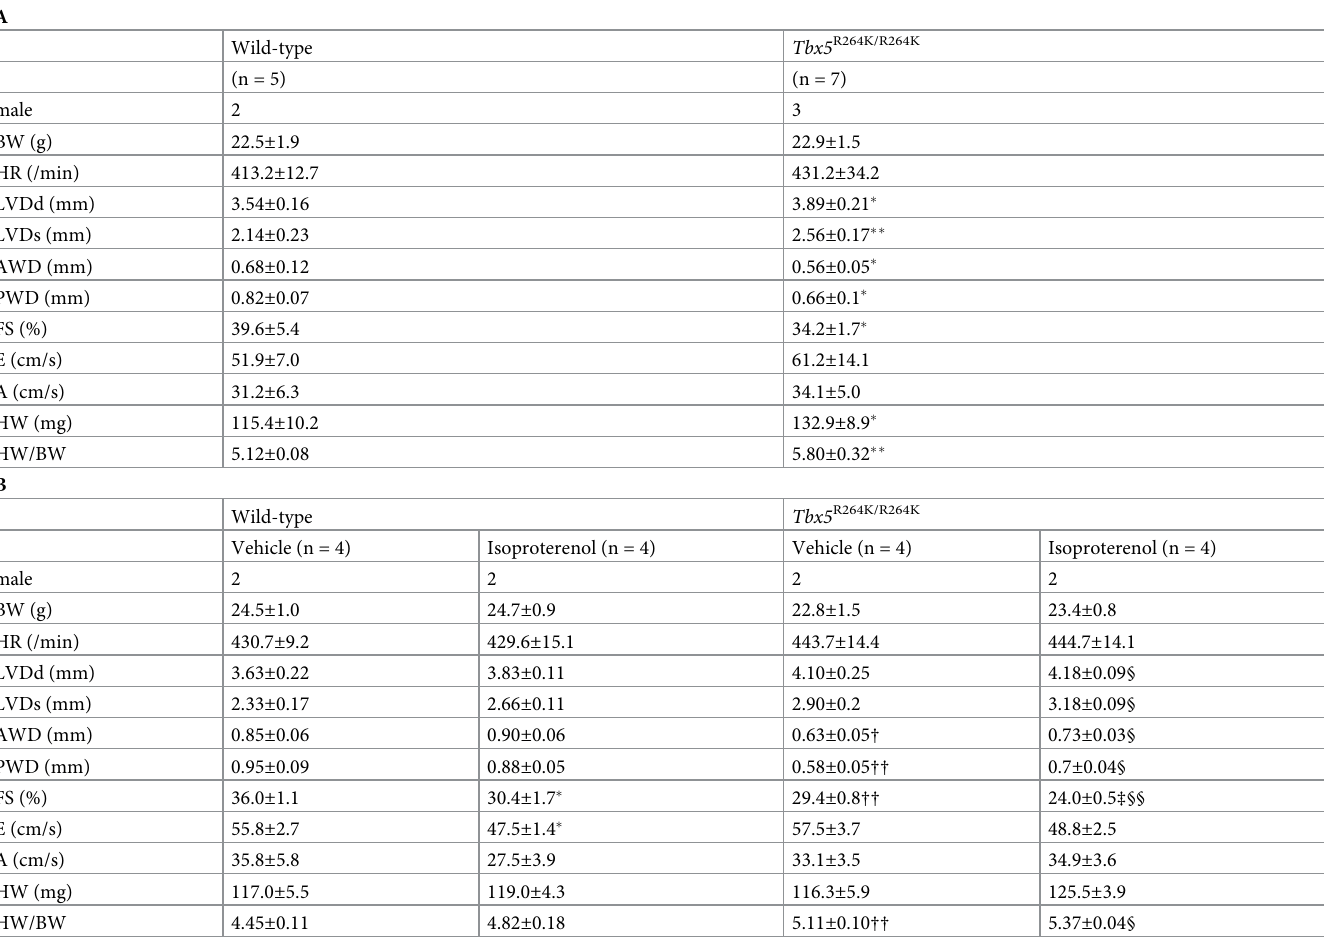
Table 2. A. Characteristics and echocardiographic data in young adult wild-type and Tbx5 R264K/R264K mice . B. Characteristics and echocardiographic data of isoprotere- nol stimulation in young adult wild-type and Tbx5 R264K/R264K